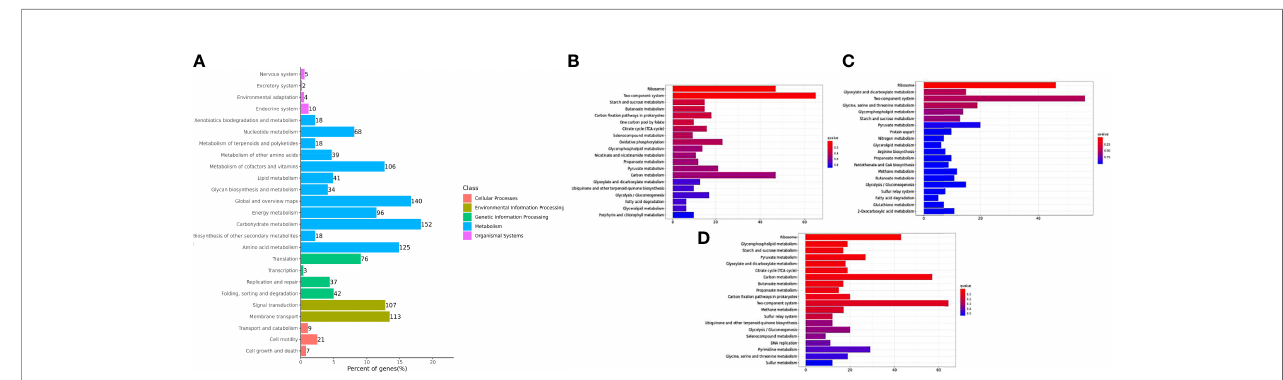
FIGURE 6 | Histogram of the top 20 enriched KEGG pathways of DEGs in Y. ruckeri at different time points. The Y-axis represents the KEGG pathway categories. The X-axis represents statistical signi fi cance of the enrichment. (A) represents the classi fi cation of total KEGG, (B) represents the top 20 KEGG enriched metabolic pathways in the C2_T6 group, (C) represents the top 20 KEGG enriched metabolic pathways in the C2_T12 group and (D) represents the top 20 KEGG enriched metabolic pathways in the C2_T24 group.